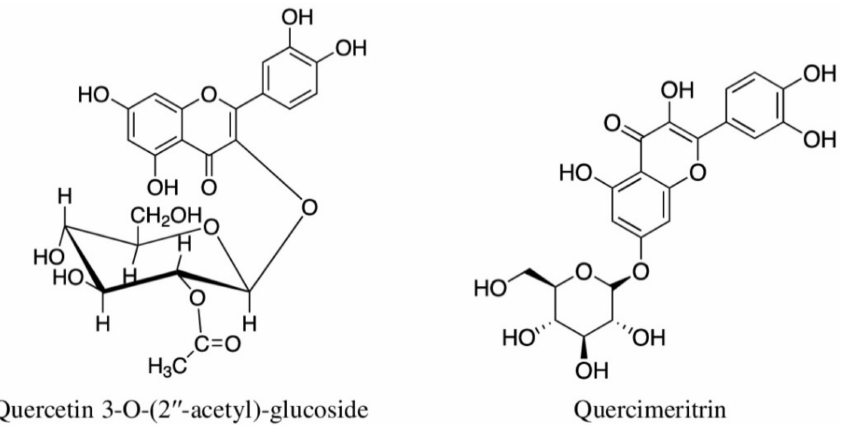
Figure 9. Chemical structures of anti-inflammatory